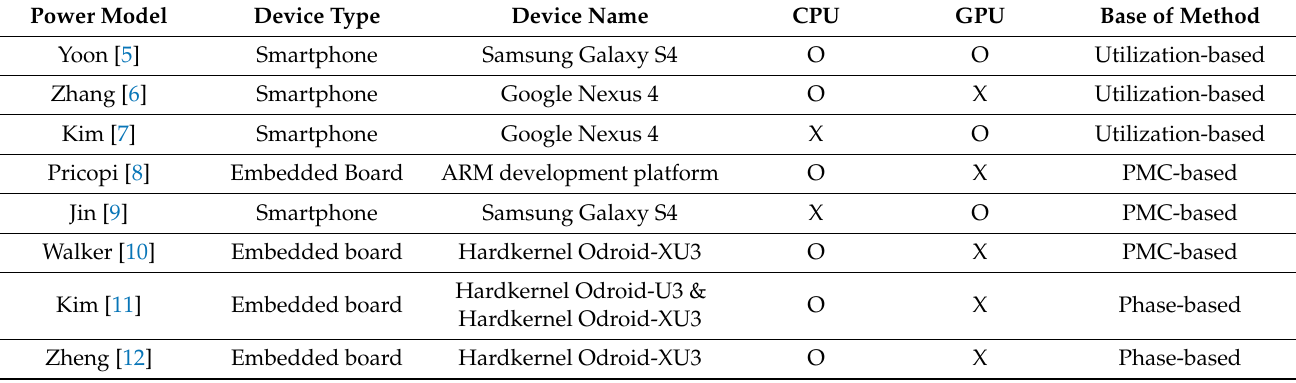
Table 1. Comparisons of the prior power models for mobile